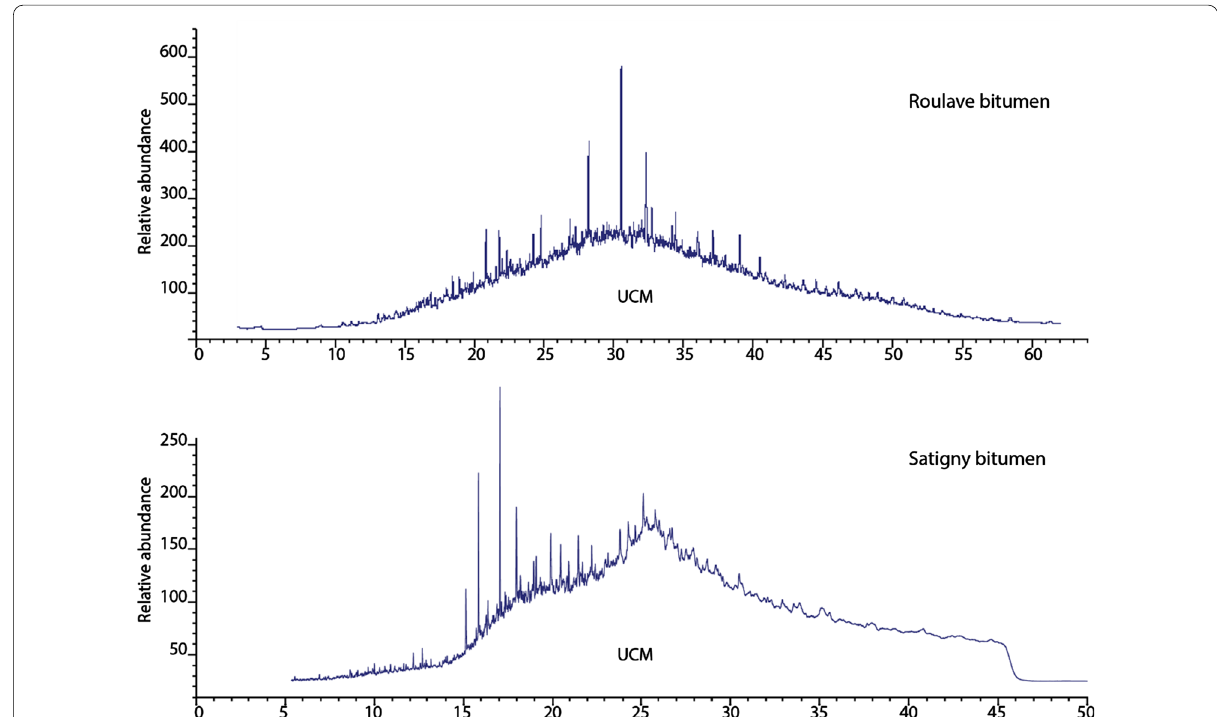
Fig. 8 Chromatogram of the Roulave and Satigny bitumens mainly displaying an unresolved complex mixture (UCM) typical of heavily biodegraded oil